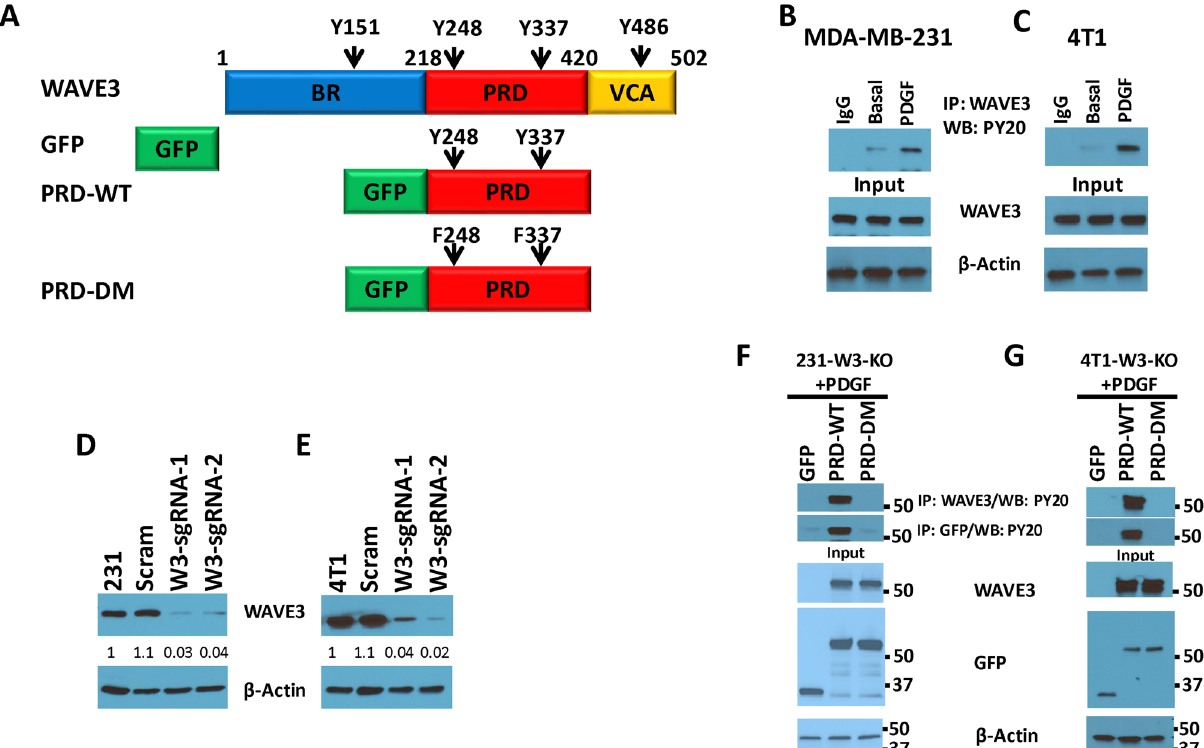
Figure 1. WAVE3 PRD domain is the host for two tyrosine residues the phosphorylation of which regulates regulate WAVE3 activity. ( A ) Graphical representation of WAVE3 functional domains and GFP-fused truncation mutants. Wild-type WAVE3-PRD domain (PRD-WT) is the host of two tyrosine residues (Y248 and Y337). The two tyrosine residues (Y248 and Y337) were mutated to unphosphorylated phenylalanine (F248 and F337), known as phospho-mutant (PRD-DM). ( B , C ) Proteins lysates prepared from MDA-MB-231 ( B ) and 4T1 ( C ) cells that treated with PDGF were used for immunoprecipitation with anti-WAVE3 antibody and subjected to immunoblotting analysis with anti-PY20 antibody. ( D , E ) Western blots developed with anti-WAVE3 antibody of protein lysates from MDA-MB-231 ( D ) and 4T1 ( E ) cells transduced with a scrambled sgRNA (Scram), WAVE3 sgRNA-1 (W3-sgRNA-1), WAVE3 sgRNA-2 (W3-sgRNA-2). β-Actin is a loading control. ( F , G ) Protein lysates prepared from PDGF-treated WAVE3-deficient MDA-MB-231 ( F ) and 4T1 ( G ) cells that were transfected with GFP, wild-type WAVE3-PRD-GFP fusion (PRD-WT) or phospho-mutant WAVE3- PRD-GFP fusion (PRD-DM), were used for immunoprecipitation with anti-WAVE3 antibody and